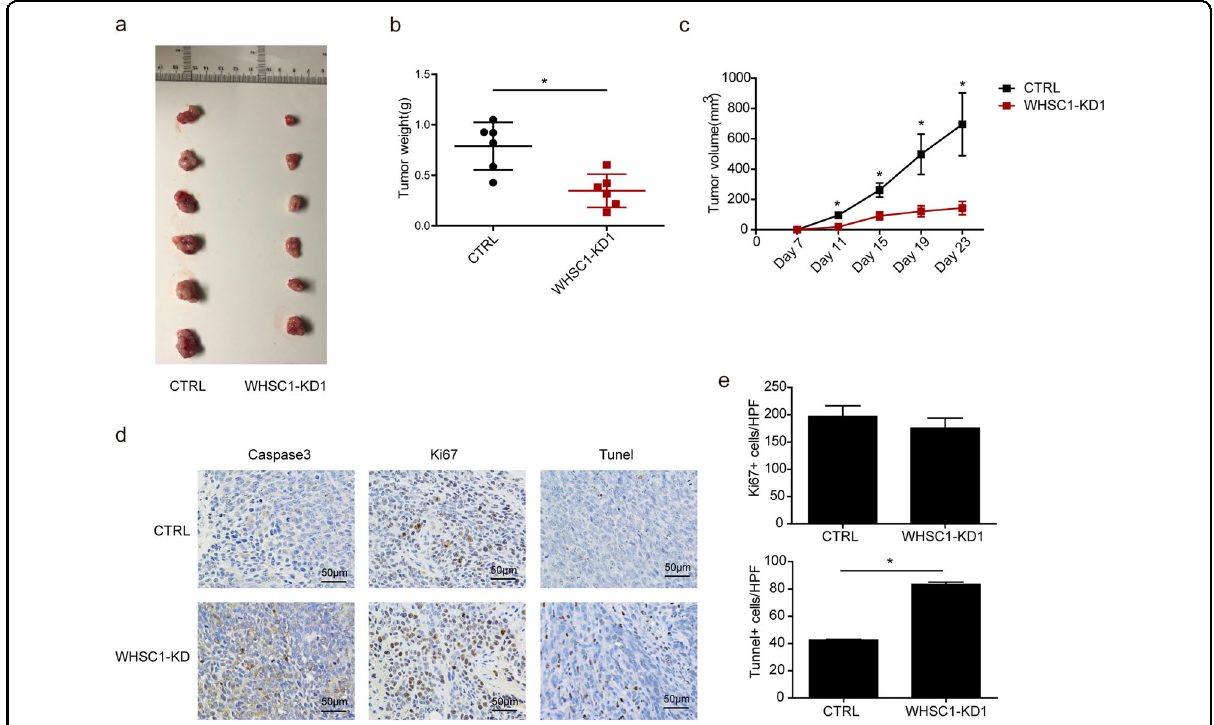
Fig. 4 WHSC1 reduction suppresses CRC cell growth and promotes apoptosis in vivo. a Tumor growth in mice injected with HCT116 cells stably expressing shWHSC1-1 or the control. b , c Tumor volume ( b ) and volume weight ( c ) in mice injected with HCT116 cells stably expressing control or shWHSC1-1 ( n = 6). d , e Immunohistochemistry results for TUNEL and caspase3 assays of tumors derived from HCT116 cells stably expressing control or